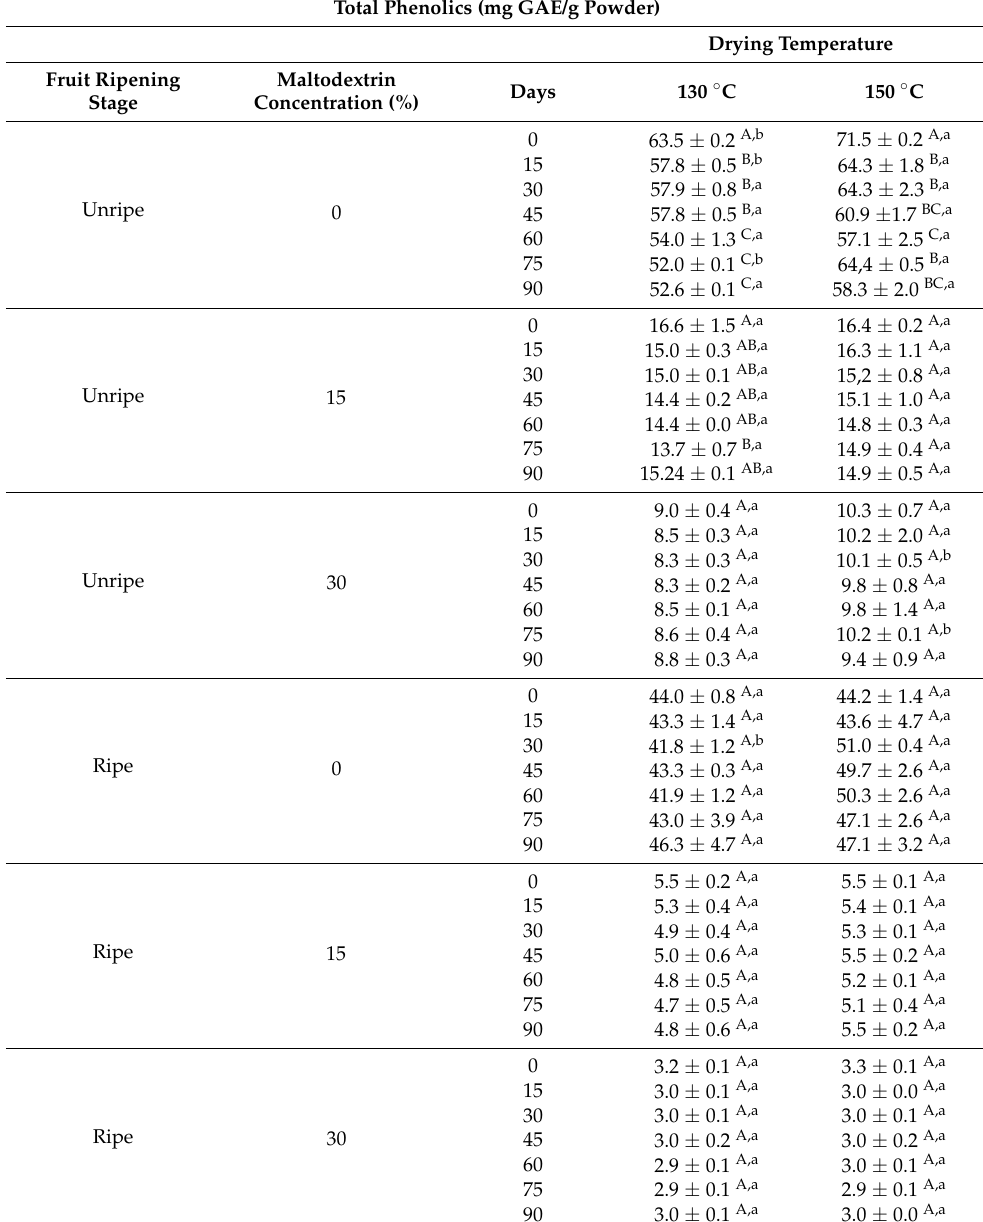
Table 5. Stability of total phenolics of spray-dried powders from papaya seed extracts with maltodex- trin as a